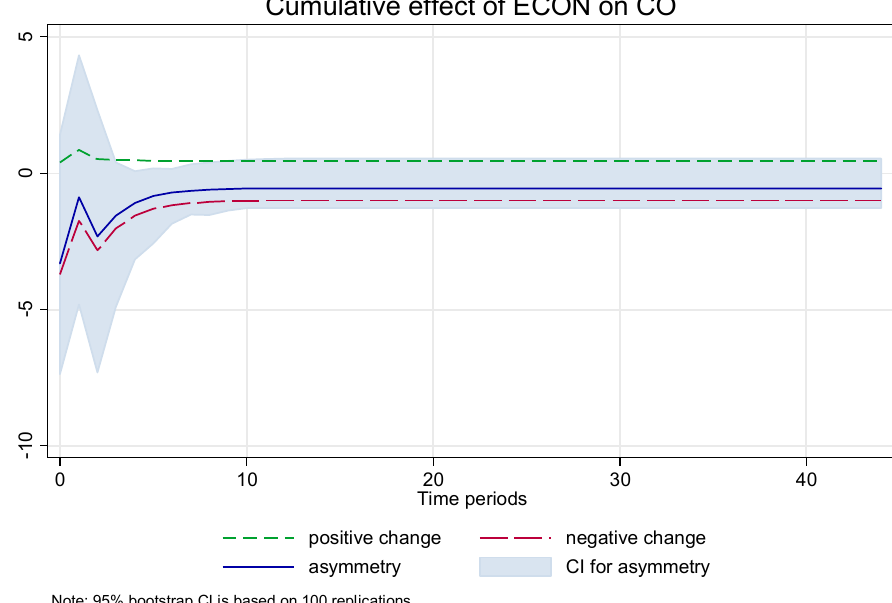
Figure A2. Cumulative effect of ECON on CO.